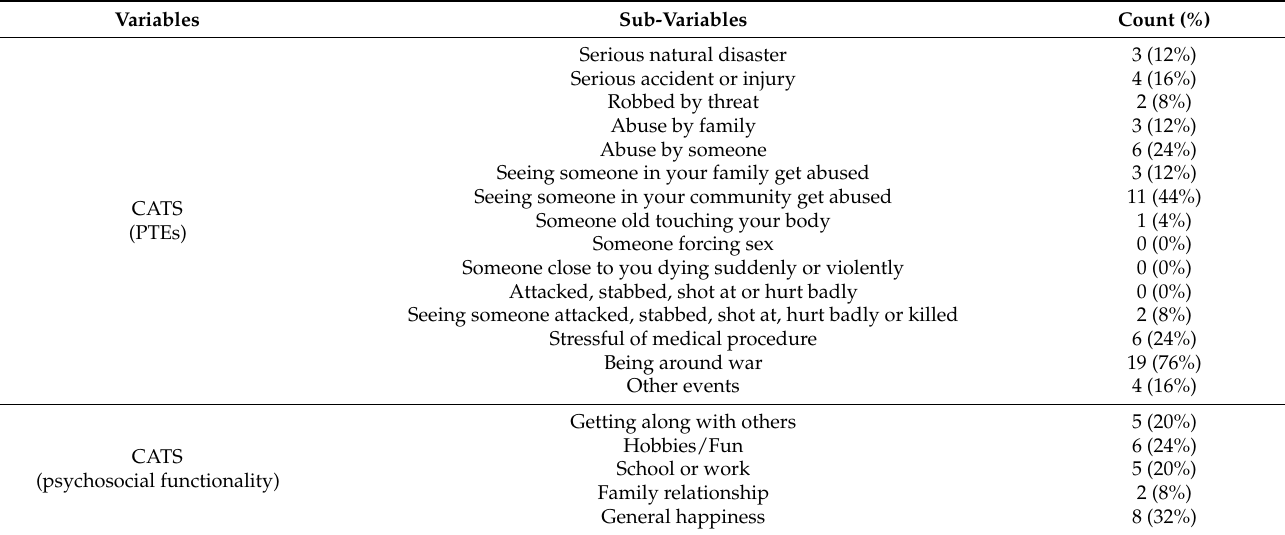
Table 3. The screening test results of CATS (PTEs), CATS (psychosocial